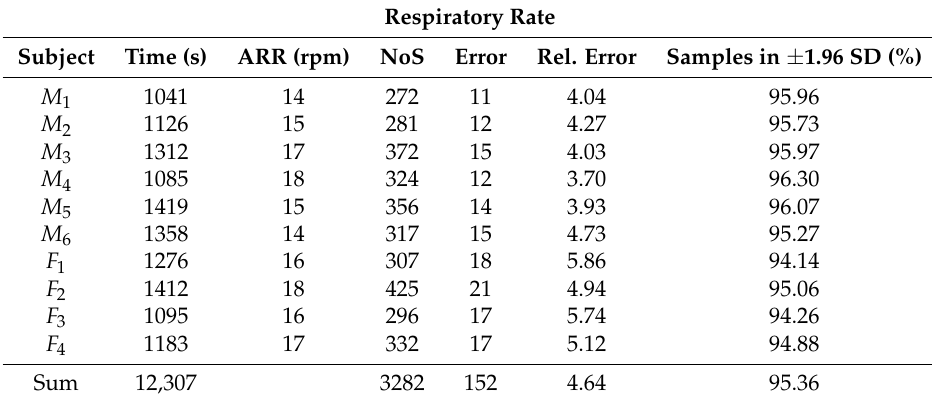
Table 2. Summary of respiratory rate measurements.